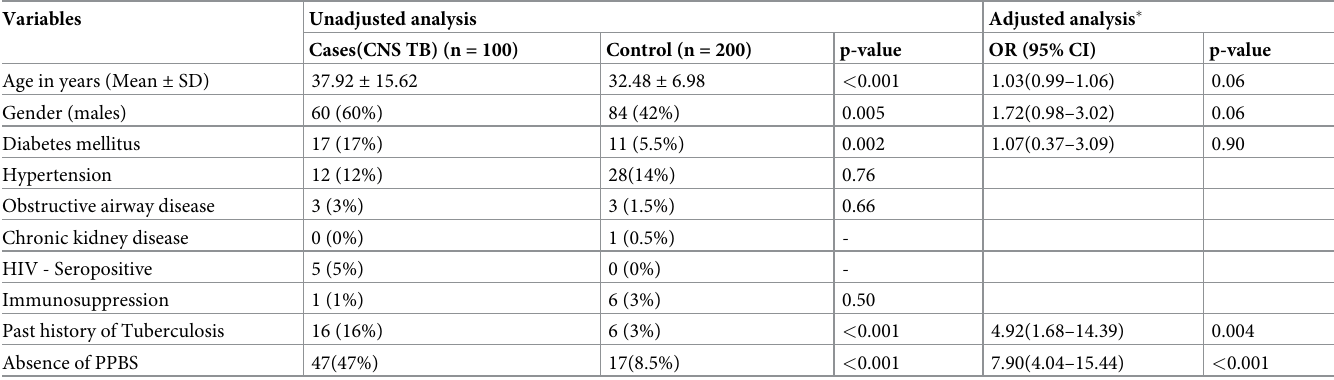
Table 2. Baseline characteristics of the cases and controls.